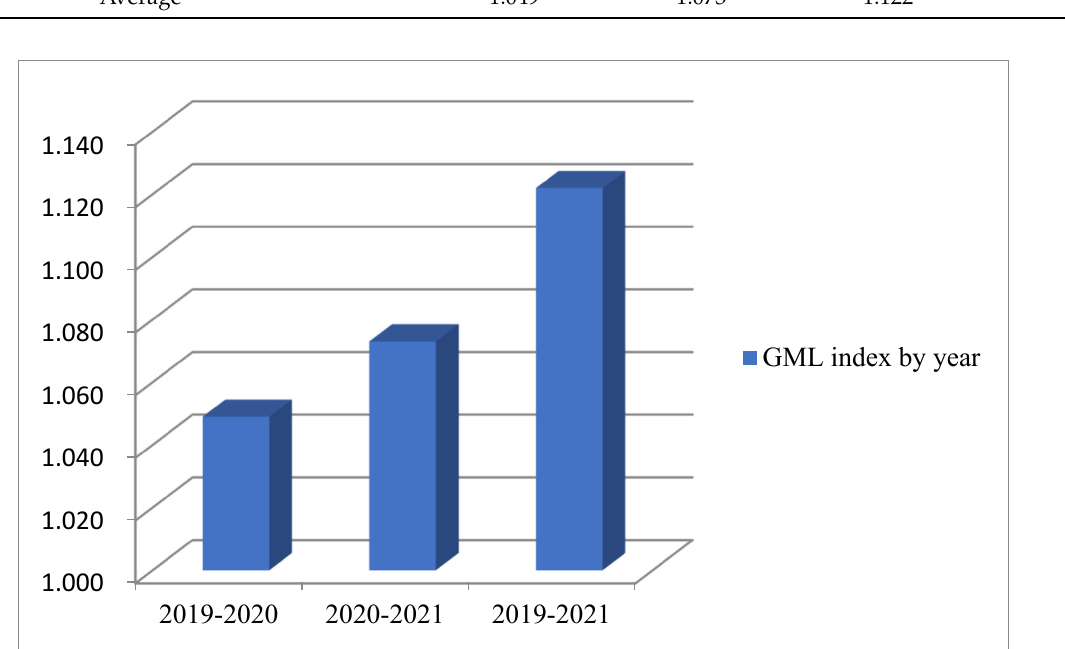
Figure 5. GML index of rural preservation and inheritance value assessment by year in the Western Liao River Basin, Inner Mongolia, China.